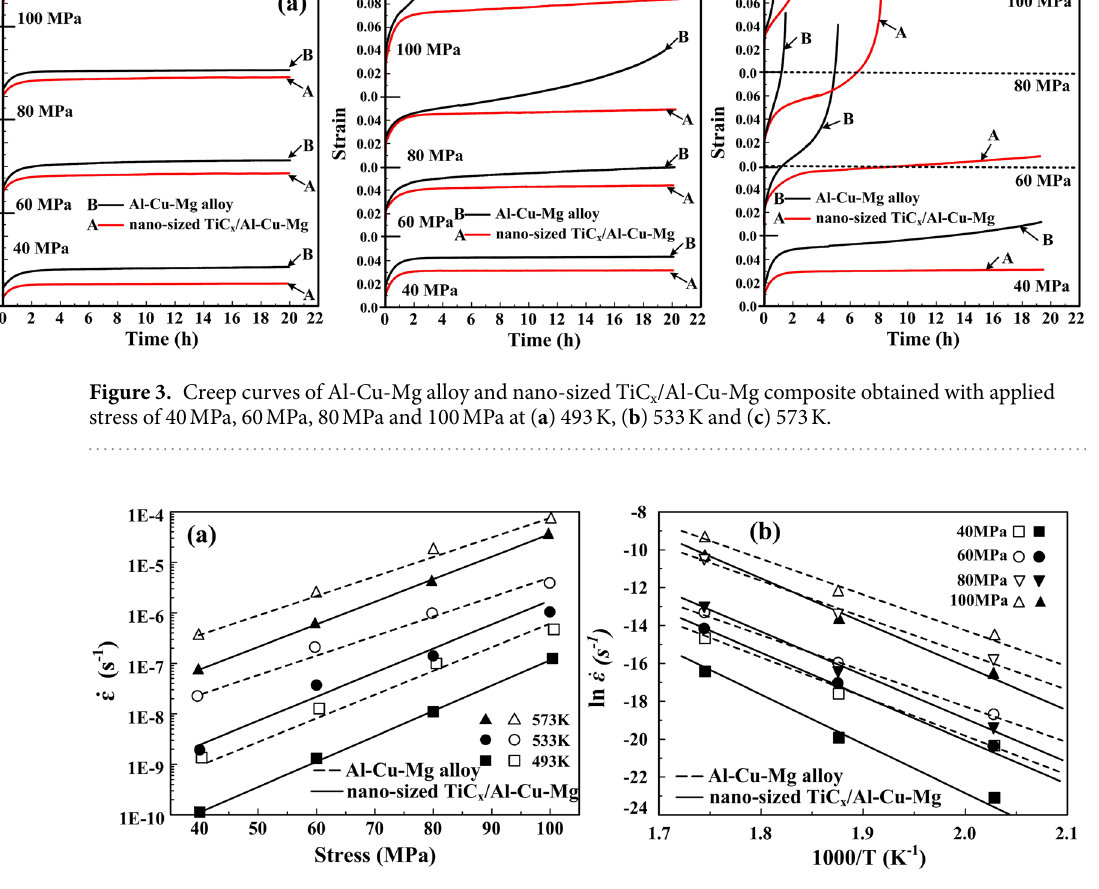
Figure 4. ( a ) Variation of ε  with the applied stress ( σ ) for Al-Cu-Mg alloy and the composite at 493 K, 533 K m and 573 K; ( b ) the plots of ε  ln versus 1000/T for the Al-Cu-Mg alloy and the composite at various applied stress.